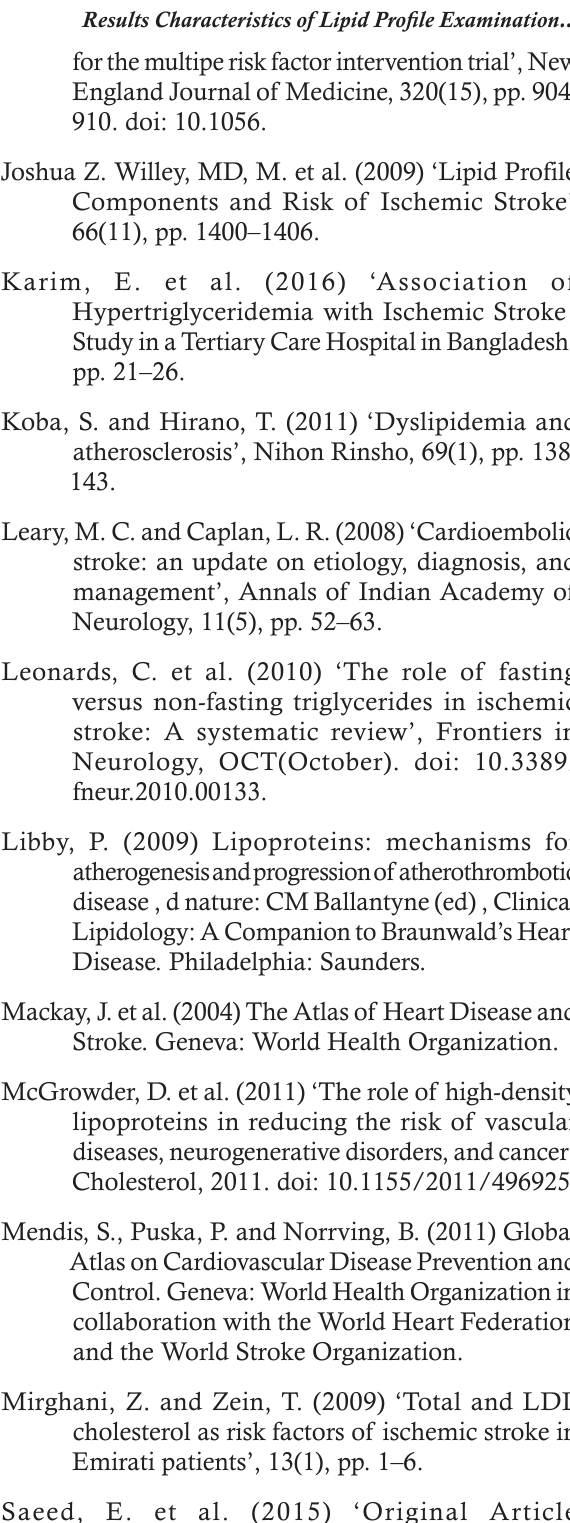
Results Characteristics of Lipid Profile